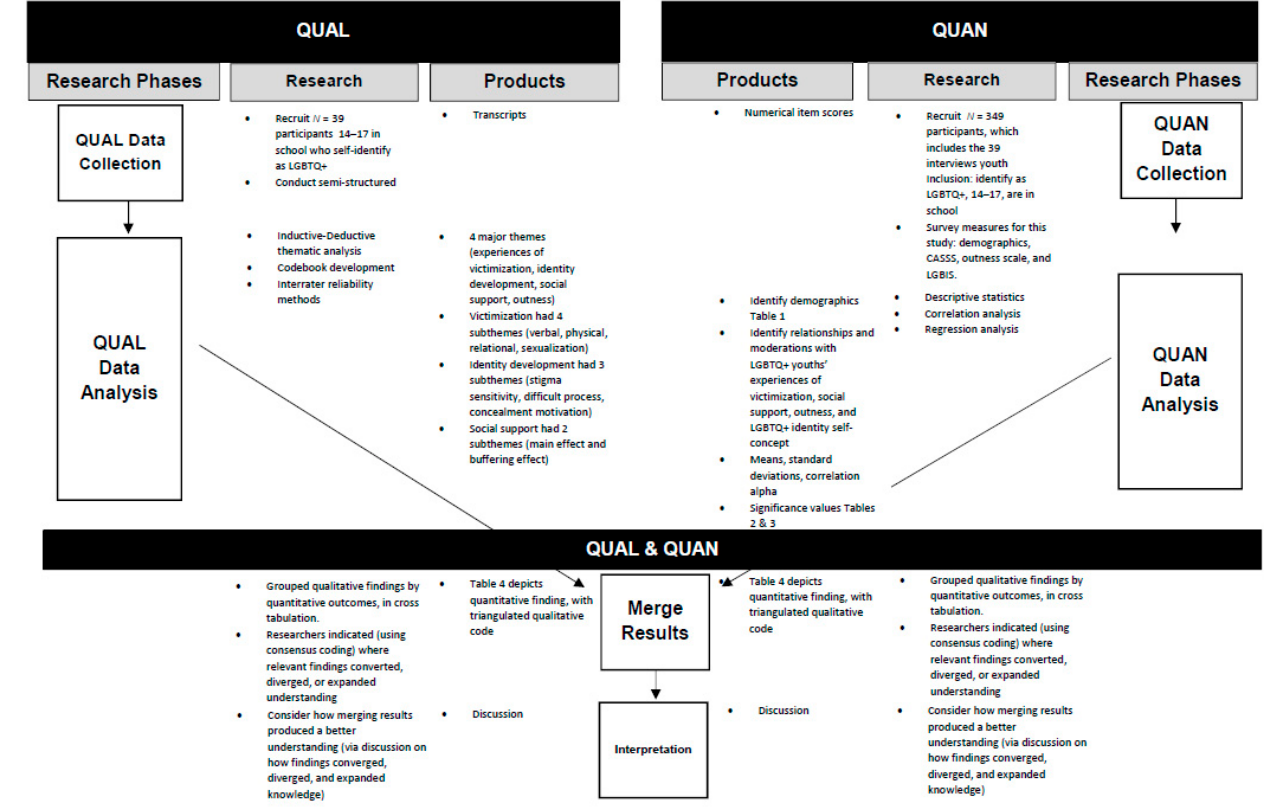
Figure 1. Concurrent Mixed Methods Study Design.